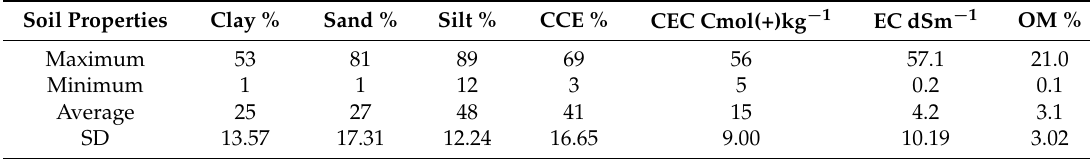
Table 1. Variation of the content of KSP as conditioning factors in the study